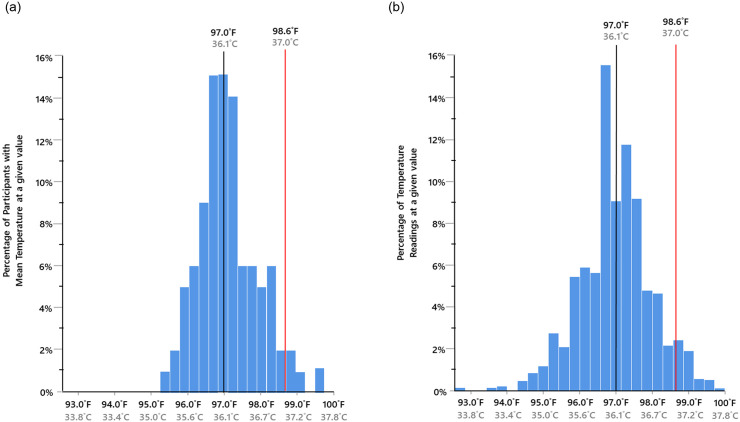
Distribution of the Mean Oral Temperatures of the 96 Study Participants (a). Distribution of all Oral Temperature Datapoints (N = 1,333)(b) 97.0°F indicates the mean body temperature across participants.